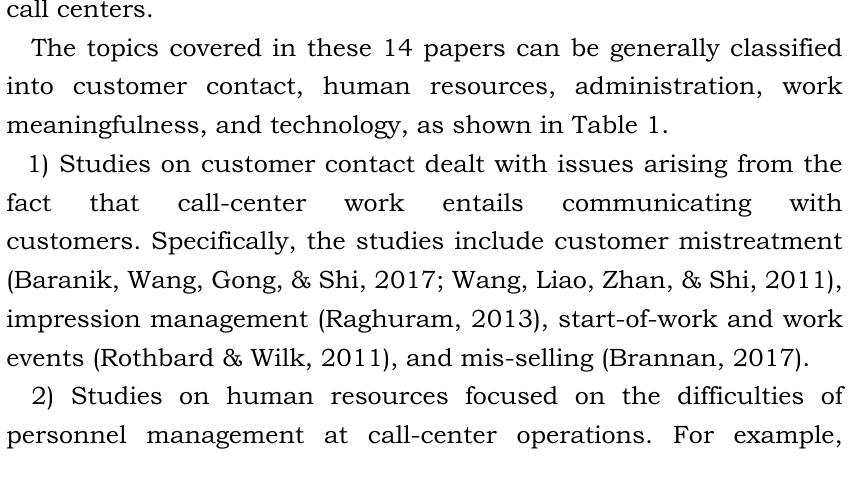
Table 1. Call center research from 2009 to 2017